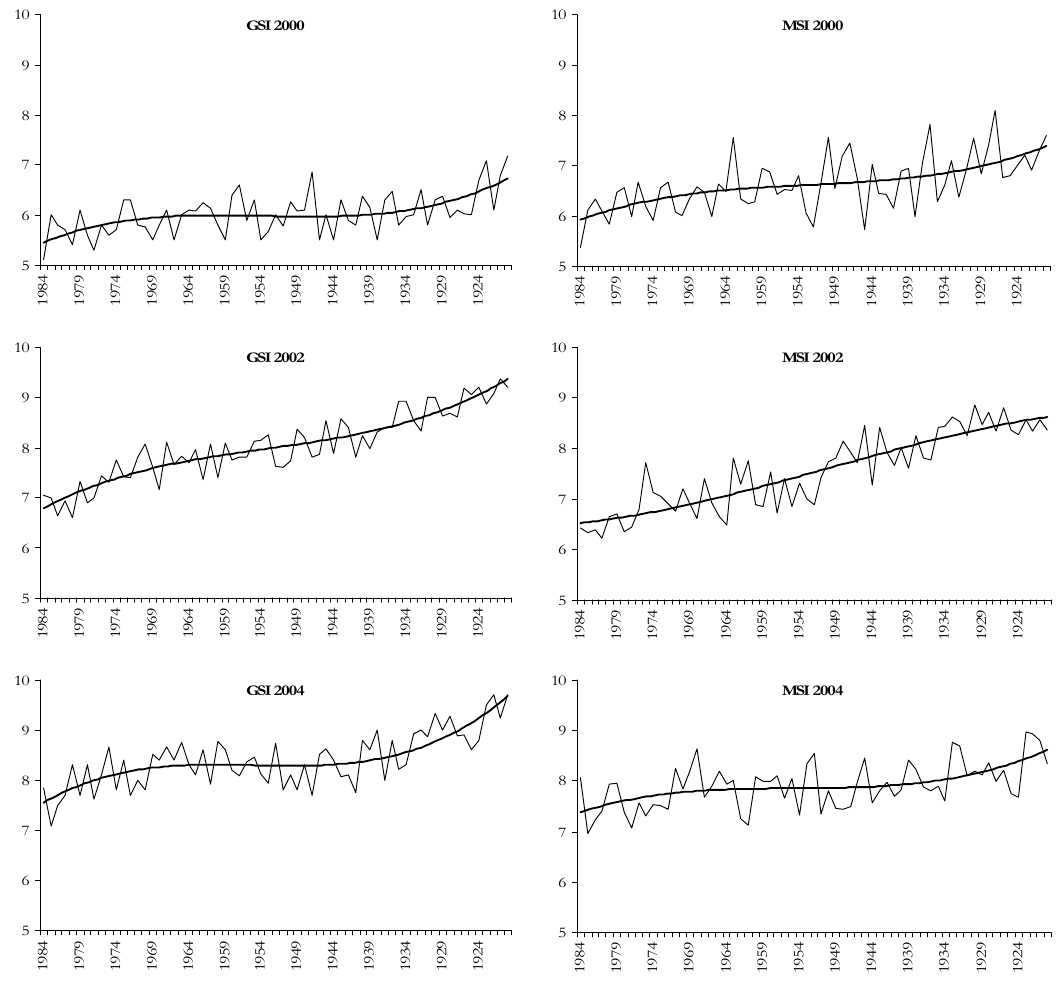
Figure 4 – The profiles of Global Satisfaction Index (GSI) and Mean Satisfaction Index (MSI) over age in 2000, 2002 and